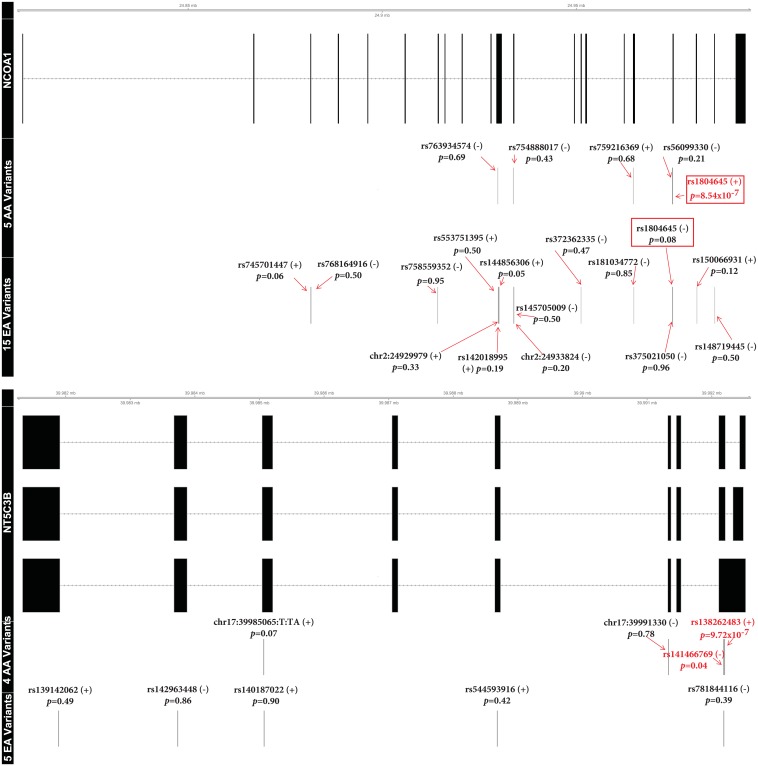
Variants contributing to the significant SKAT gene-based tests.This figure displays the single-variant model results for variants contributing to the SKAT tests of NCOA1 and NT5C3B on the third visit aβ42: aβ40 ratio and fold-change in aβ42, respectively. One isoform was drawn unless the regions harboring variants differed substantially. Each contributing variant is labeled by name, single-variant association p-value, and direction of the minor allele effect. Variants with nominal (p<0.05) levels of association are in red. Overlapping variants in the two racial groups are encapsulated by a red box.